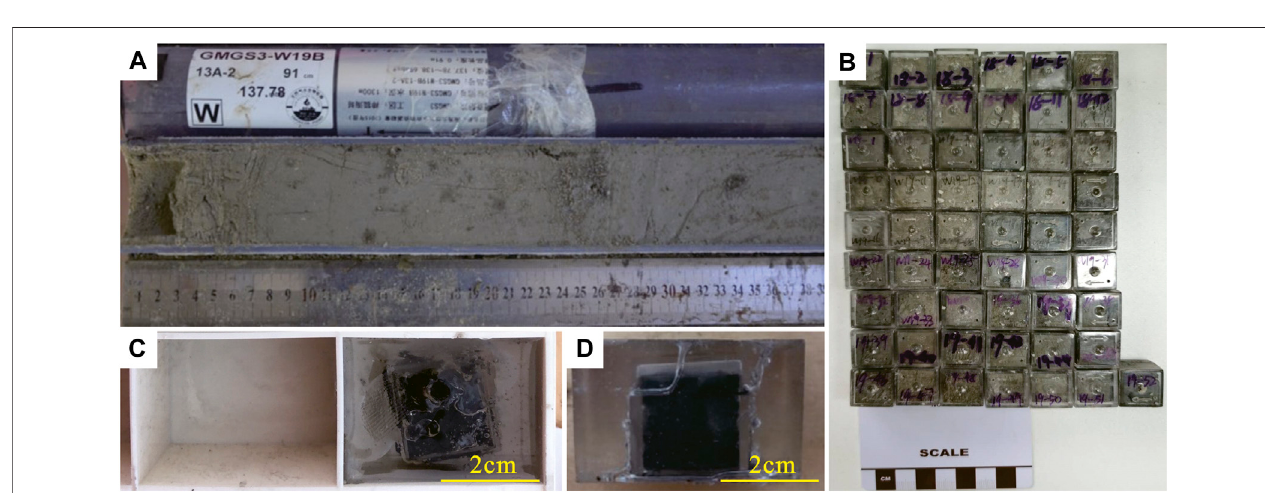
FIGURE 2 | The sampling method images. (A) the sediment cores of Site W19; (B) the sample cubes for microstructure analysis which sampling from sediment cores; (C) and (D) the images of sample preparation